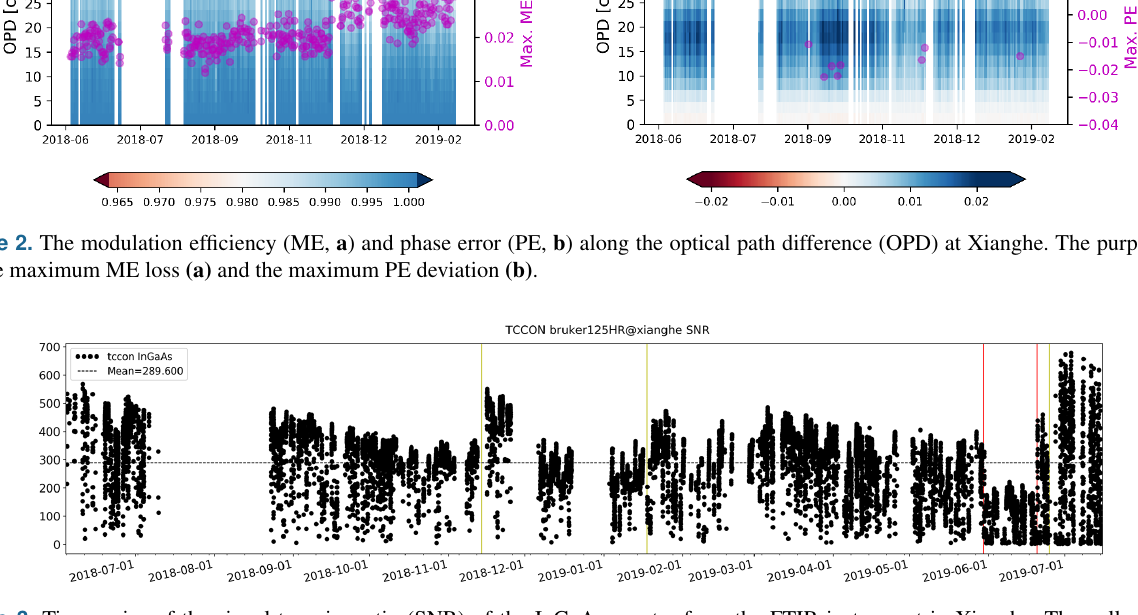
Figure 3. Time series of the signal-to-noise ratio (SNR) of the InGaAs spectra from the FTIR instrument in Xianghe. The yellow lines indicate solar tracker maintenances: cleaning of the mirrors on 14 November 2018 and 25 June 2019 and replacement of the degraded mirror on 1 February 2019. The first red line indicates the day when we add DC signal recording (31 May 2019), and the second red line indicates the day when the aperture was increased from 0.5 to 0.8mm (19 June